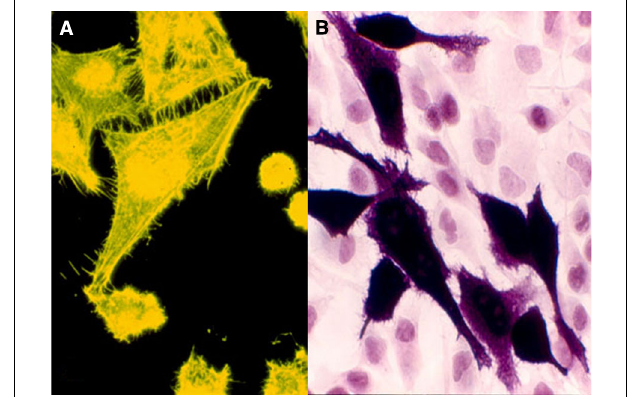
FIGURE 2 | Morphology of cultured cells with overexpressed BVR. (A) HEK cell transfected with an EGFP-BVR fusion plasmid shows a flattened morphology atypical of the parent cell line. Adapted from (Maines, 2005). (B) Similarly, HeLa cells transfected at low efficiency with a human BVR expression plasmid and analyzed by immunohistochemistry with antibody against BVR are apparently enlarged relative the surrounding lawn of untransfected cells.